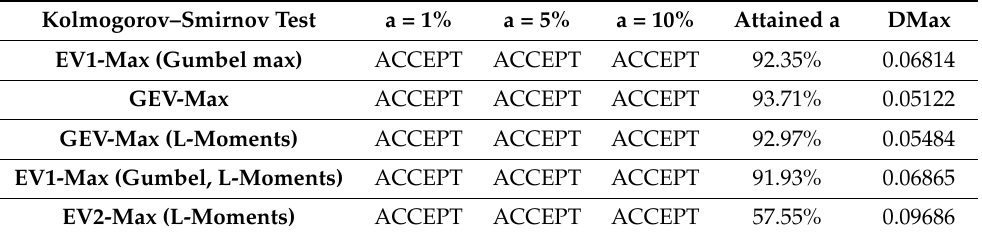
Table 4. Distributions’ performance subjected to Kolmogorov–Smirnov test.